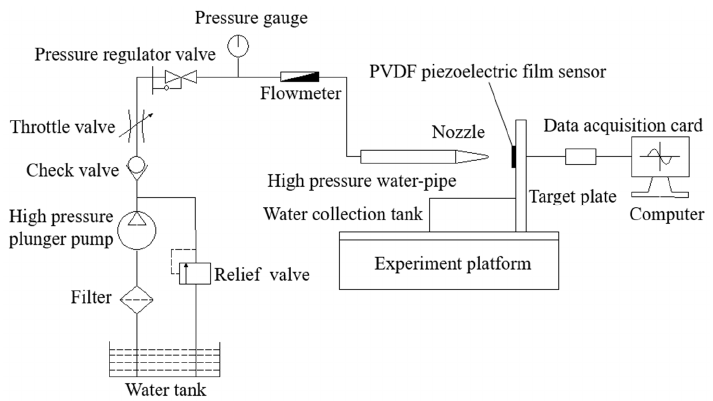
Figure 1. Schematic of the water jet performance test system.